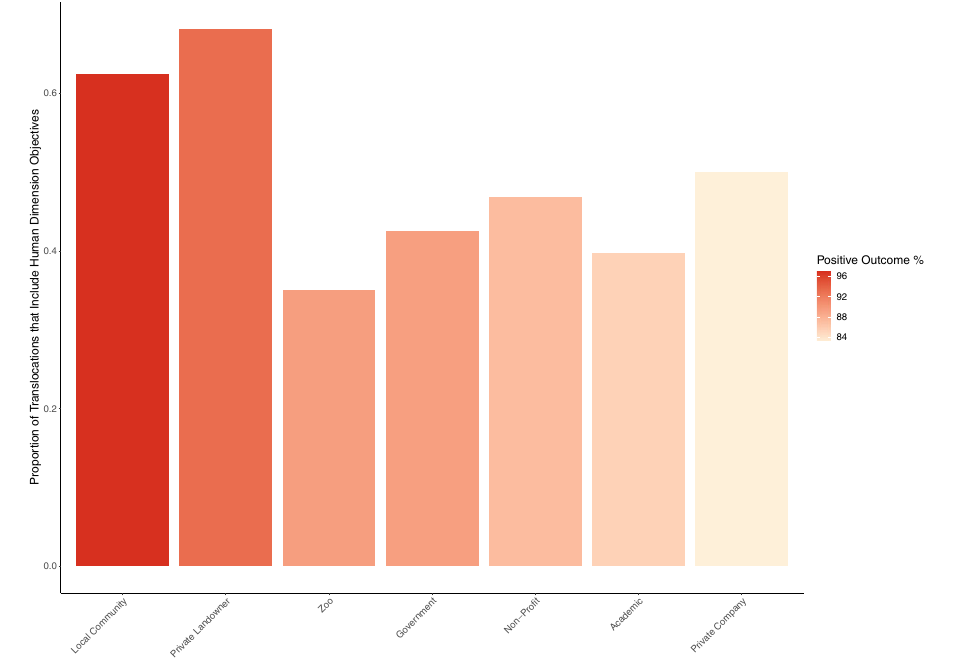
Fig. 2 | Active inclusion of local stakeholders is linked to improved transloca- tionoutcomes. BarsindicatetheproportionofstudiesreportedintheIUCNGlobal Re-introduction Perspectives Series (2008 – 2021) that incorporated human dimension objectives in their restoration project varied based on the types of groupsinvolvedintheproject.Thecolorgradientfromlighterred(lower)todarker